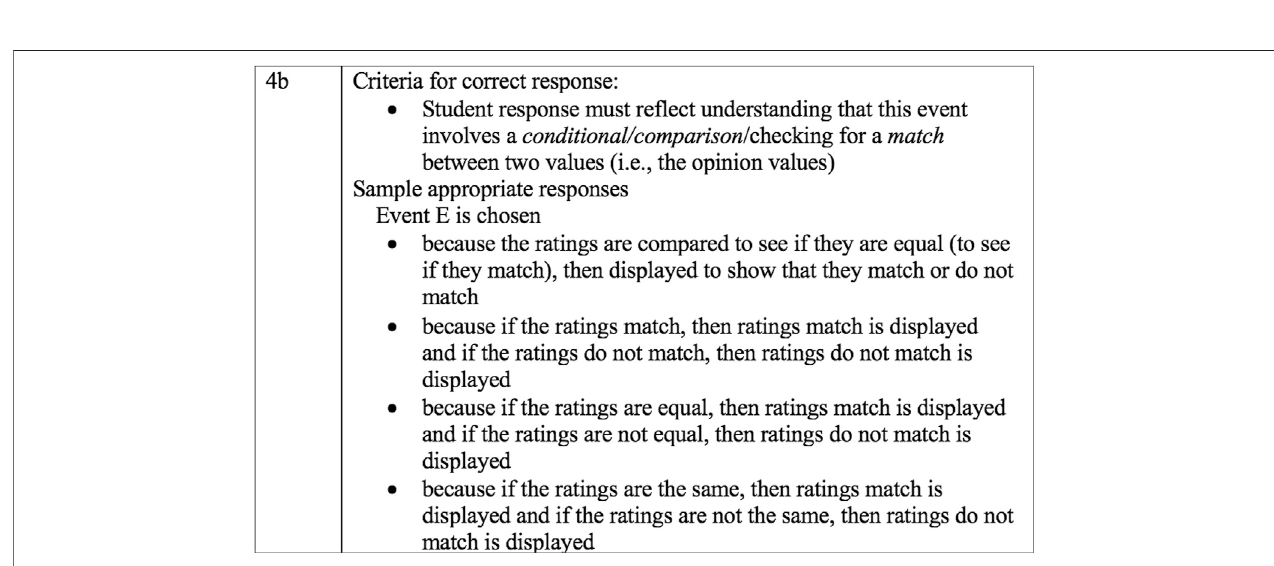
FIGURE 7 | Scoring rubric for unit 4 assessment, item